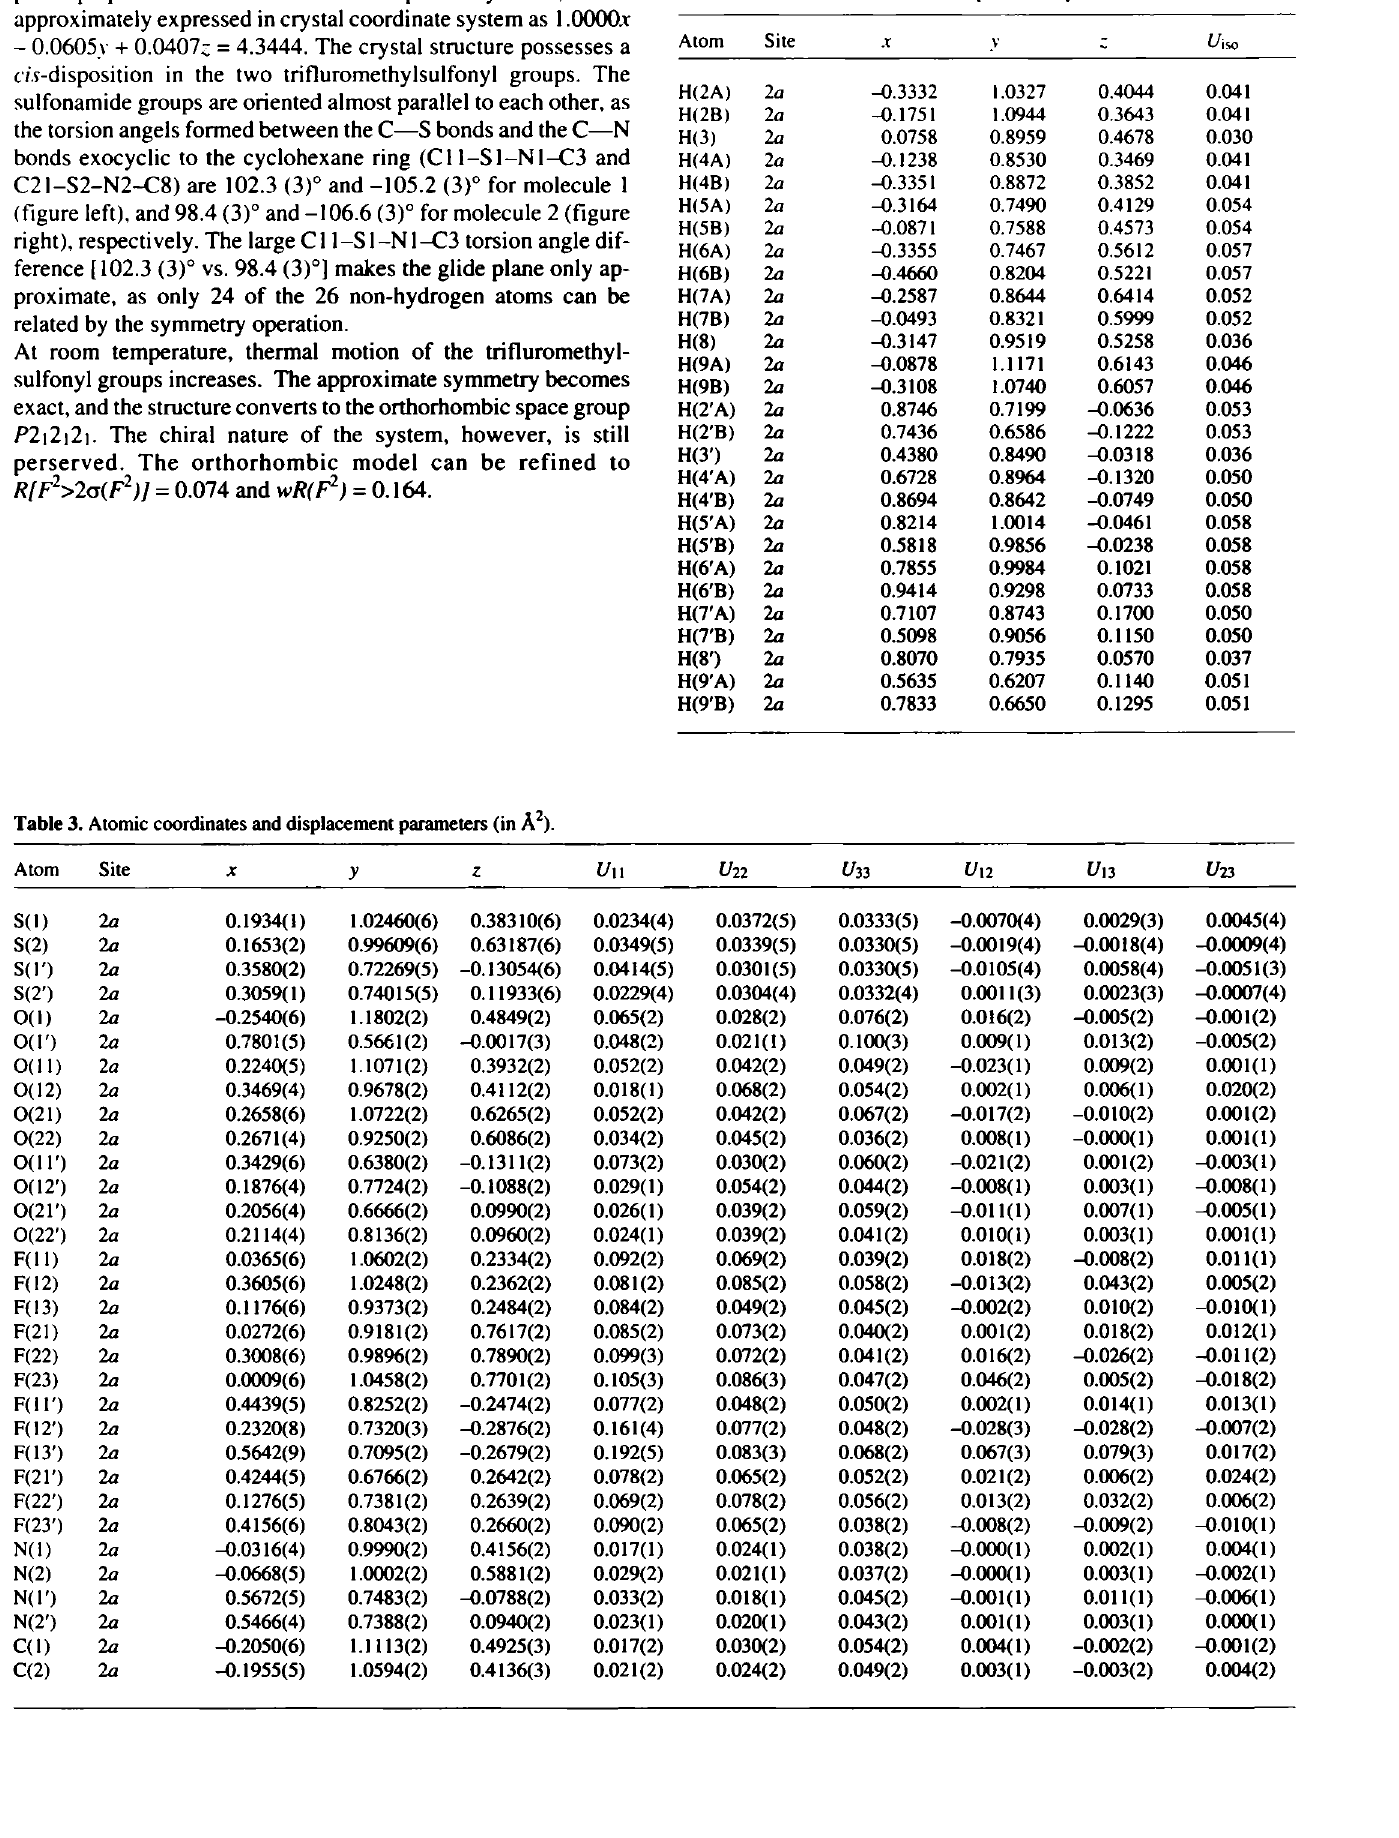
Table 2. Atomic coordinates and displacement parameters (in A : ).